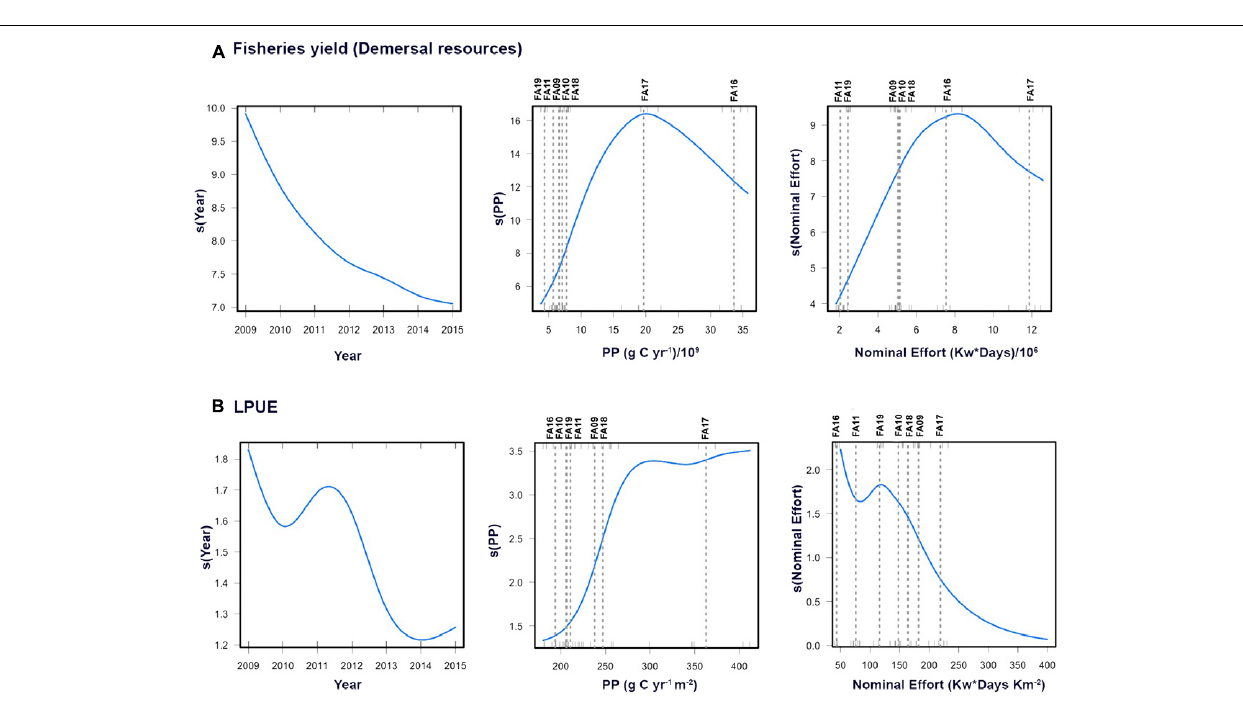
FIGURE 12 | Summary of the effect of year, PP and NE on (A) Fisheries yield and (B) LPUE across the seven FA